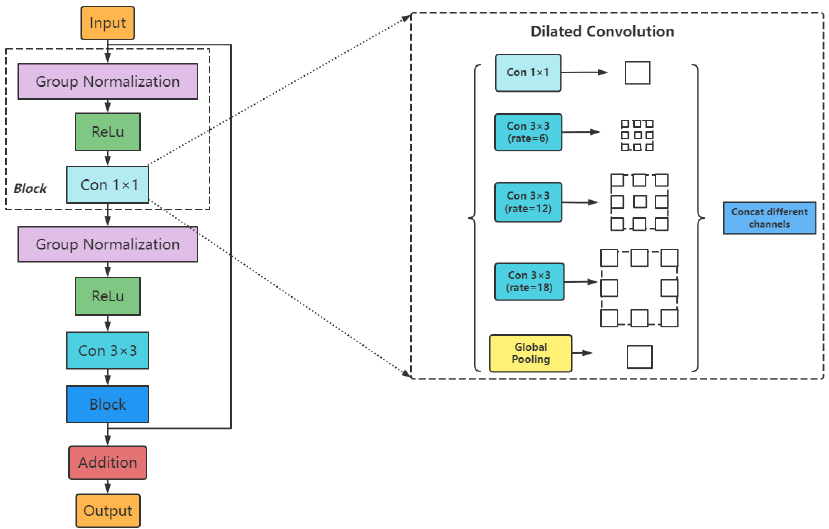
Figure 5. The architecture of improved